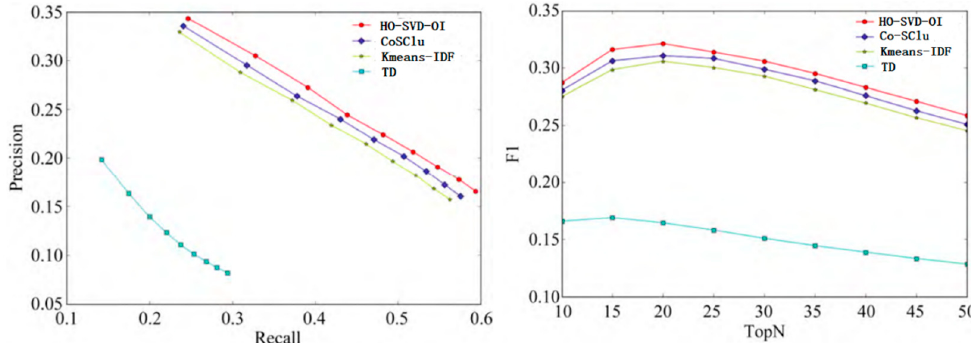
Figure 4. Simulation experiment results of the P-R curve and F1 index curve of the dataset under four algorithms.